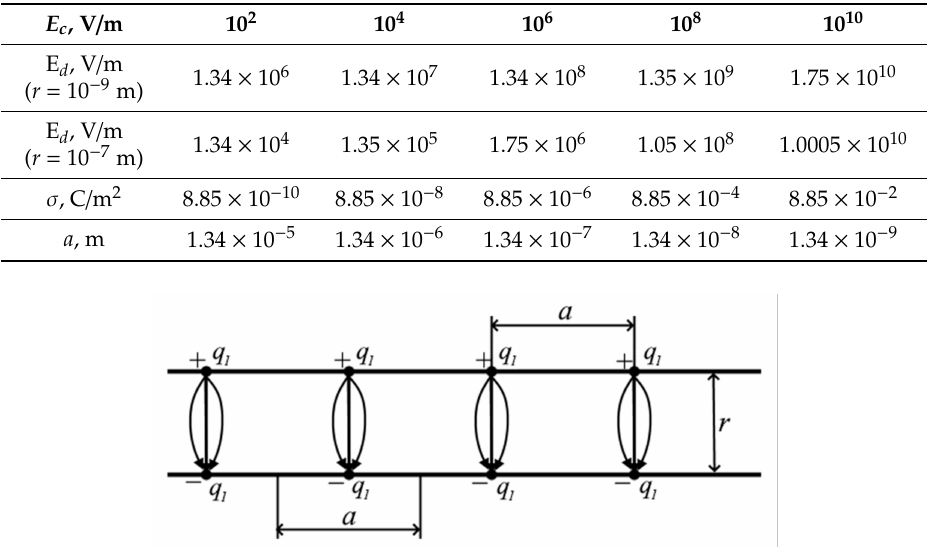
Figure 5. Pairwise interacting charges discretely distributed on the electrodes. q 1 —discrete point charges charges on the electrodes, r —distance between electrodes, a —distance between charges on a